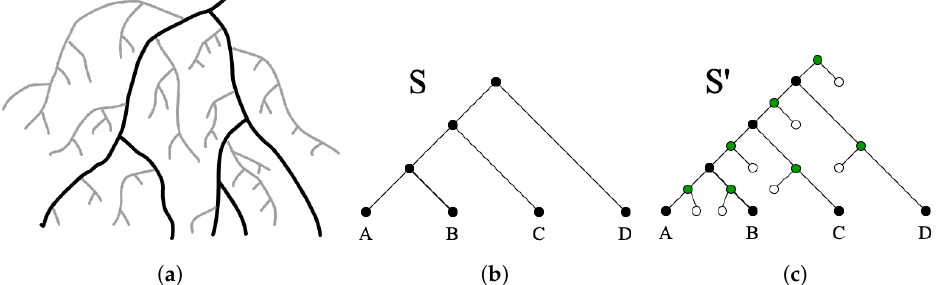
Figure 3. Representation of unsampled lineages on the species tree. ( a ) Illustration of the “coral” of life based on drawings by Darwin, where black lines represent lineages leading to extant species, and grey lines represent potential unsampled species; adapted from [28]. ( b ) Input species tree before augmentation. ( c ) Augmented species tree. Extra nodes are in green and extra leaves are in white. Leaves labeled A-D represent extant species. Unsampled lineages are represented by the edges connecting extra nodes and extra